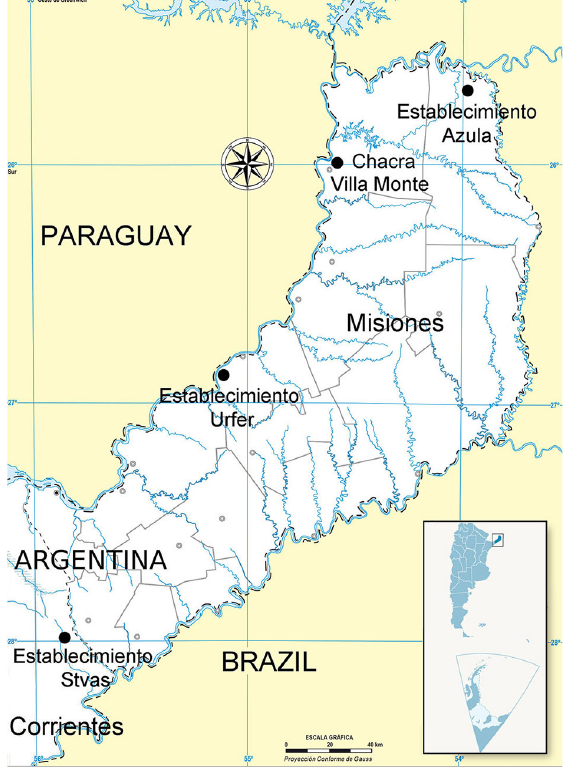
Figure 1. Map of Northeastern Argentina, with detail of Misiones Province and northeastern Corrientes Province, showing location of the “yerba mate” plantation sites surveyed in this